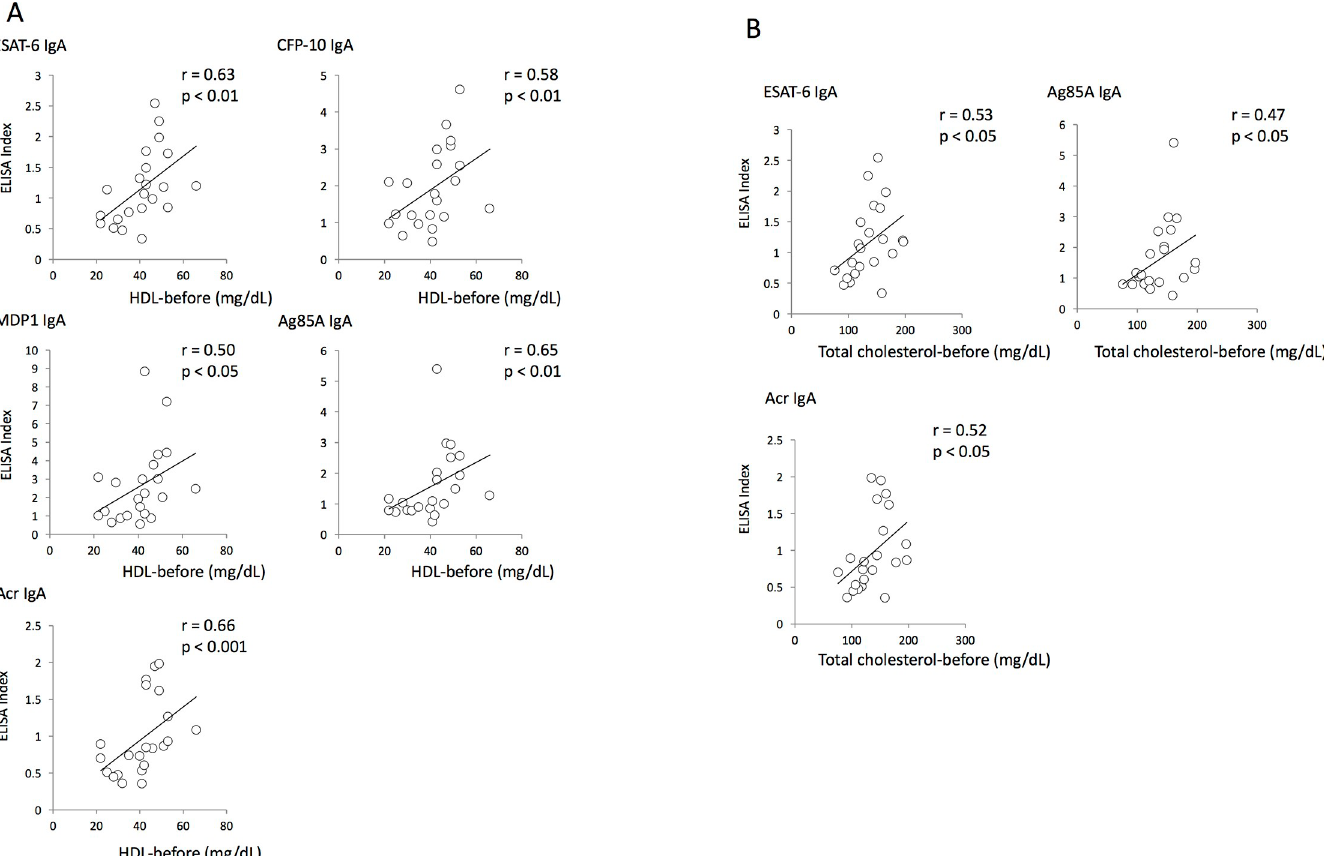
Fig 5. Correlation between antibody levels and nutritional status before and after treatment. (A) Correlation between serum HDL concentrations and serum IgA levels specific to Mtb antigens before TB treatment. (B) Correlation between serum total cholesterol levels and serum IgA levels specific to Mtb antigens before TB